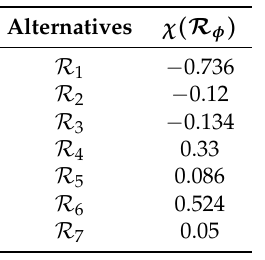
Table 16. Net flow of